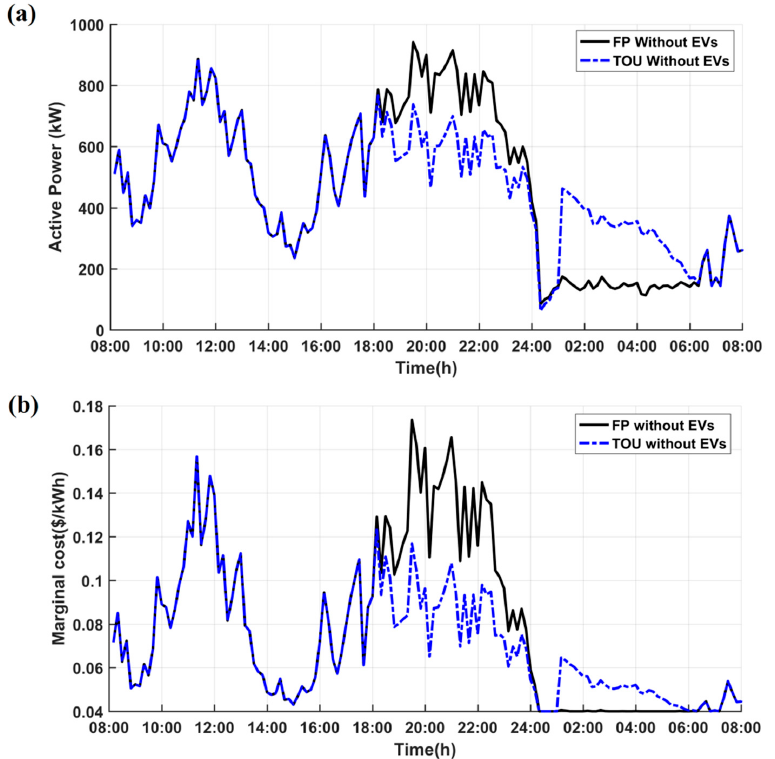
Figure 5. ( a ) Total active power and ( b ) Marginal cost of the FR and TOU, in a grid with no EV.